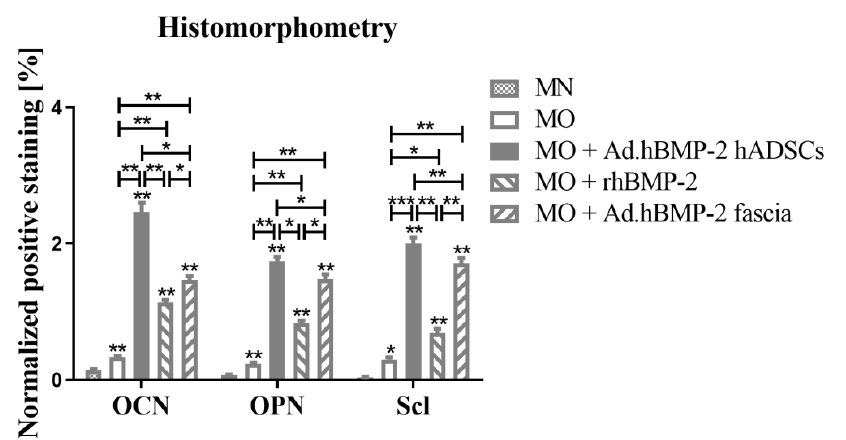
Figure 10. Immunofluorescent staining of hADSC-seeded scaffolds treated by different hBMP-2 delivery modes after 4 weeks of incubation. Samples treated with MN ( A1 – A3 ); MO ( B1 – B3 ); MO + Ad.hBMP-2 hADSC ( C1 – C3 ); MO + rhBMP-2 ( D1 – D3 ); MO + Ad.hBMP-2 fascia ( E1 – E3 ). Immunofluorescent staining products of OCN, OPN and Scl are presented in green; nuclei of cells stained with DAPI are presented in blue. Scale bar = 200 μm .